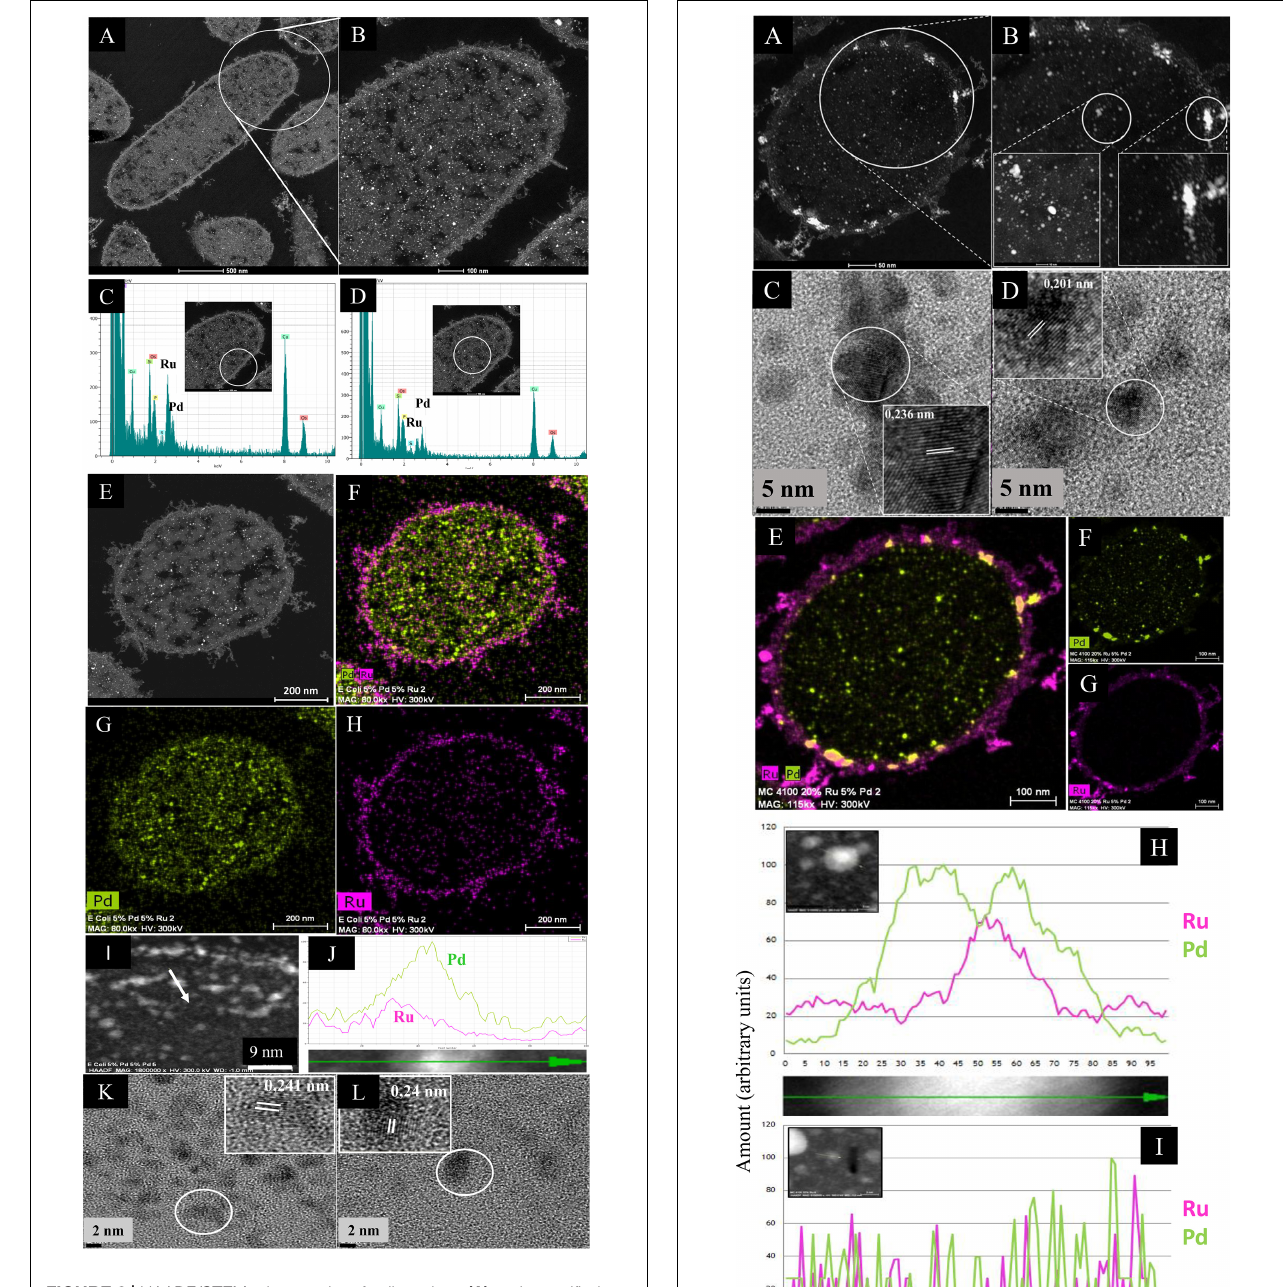
FIGURE 2 | HAADF/STEM micrographs of cell sections (A) and magnified view. Bars are 500 nm (B) of 5 wt% Pd/5 wt% Ru NPs. Bars are 100 nm. EDX is shown of the cell surface (C) and intracellular (D) regions. A single cell (E) is shown mapped for areas of Pd (G) and Ru (H) localization and co-mapped to show distribution of the two elements (F) . Bars are 200 nm. An enlarged image of panel (F) is shown in Supplementary Figure S4 to show overall lack of co-mapping of the two elements on visual inspection but also that intracellular Ru is very evident. An example NP in the cell surface region ( I , arrowed; scale bar is 9 nm) was analyzed by transect (J) to show association between Pd (green) and Ru (magenta), especially evident on one side of the NP as a skewed distribution. The green arrow (bottom) shows distance across the transect (as a percentage 0–100%) and the Y -axis is counts (arbitrary). (K,L) HRTEM images of single NPs from membrane-bound (K) and cytoplasmic (L) NPs showing lattice fringes. Scale bar is 7 nm.